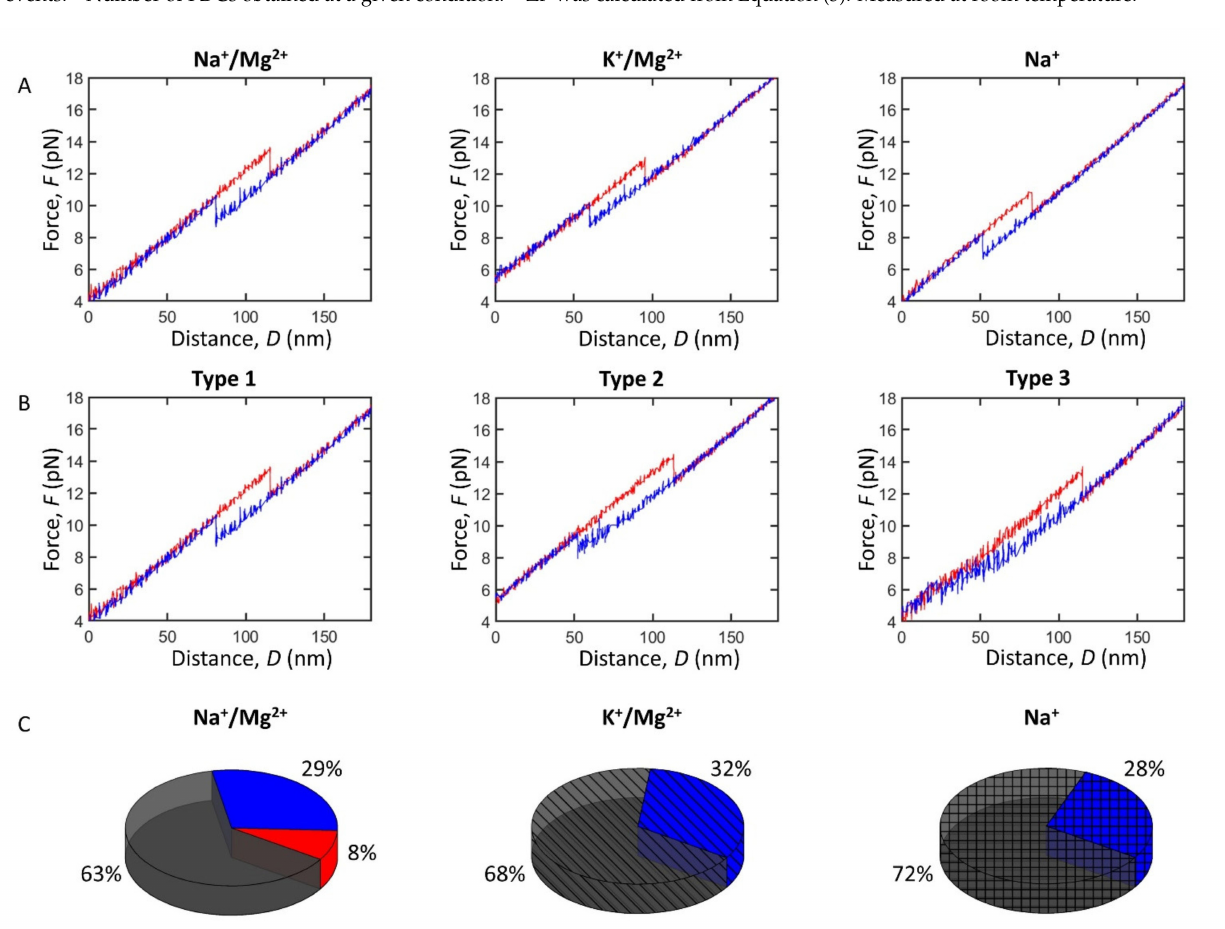
Figure 2. The WT pre-miRNA-377 stability and dynamics. ( A ) Force–distance curves (FDCs) type 1 of the pre-miRNA-377 hairpin’s single-step unfolding (red) and single-step folding (blue) in different buffers. Representative FDCs are plotted, and force distributions can be viewed in Figure S1. ( B ) Three types of pre-miRNA-377 FDCs observed in the Na + /Mg 2+ buffer: type 1 (single-step unfolding and single-step folding), type 2 (single-step unfolding and multi-step folding), and type 3 (single-step unfolding and gradual, i.e., no clear step, folding). Representative FDCs are plotted, and force distributions can be viewed in Figure S1. ( C ) The fractions of folding FDCs for pre-miRNA-377 displaying type 1 (gray), type 2 (blue), and type 3 (red) behavior in different buffers (Na + /Mg 2+ —plain, K + /Mg 2+ —striped, Na +